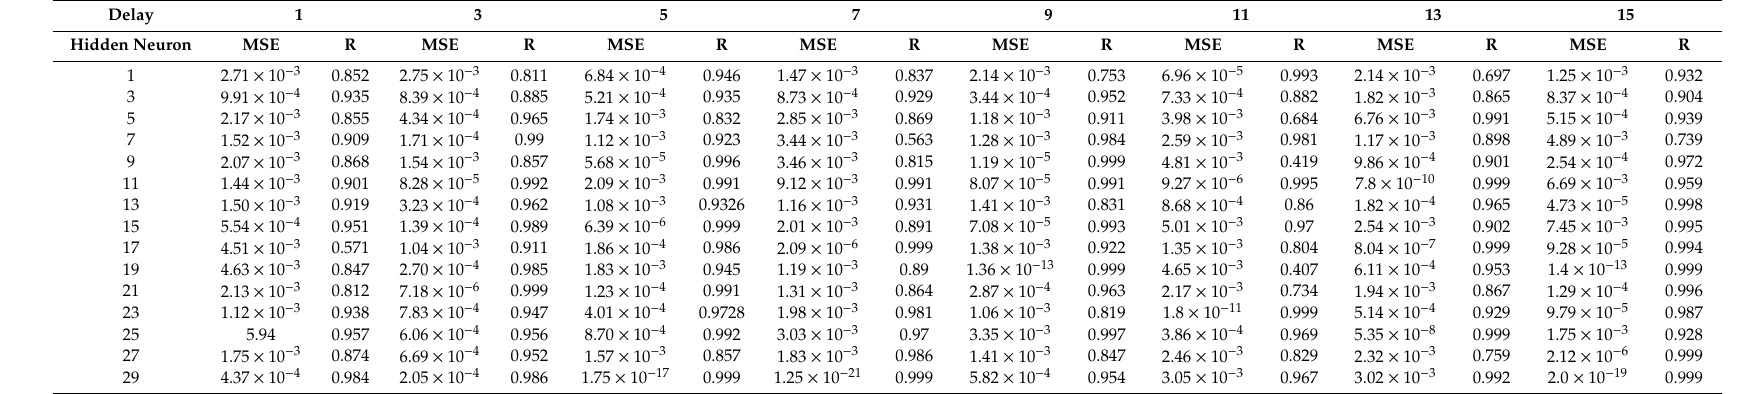
Table A3. Detail results of the optimization of the hidden neurons at varying delay using training data for Indonesia.